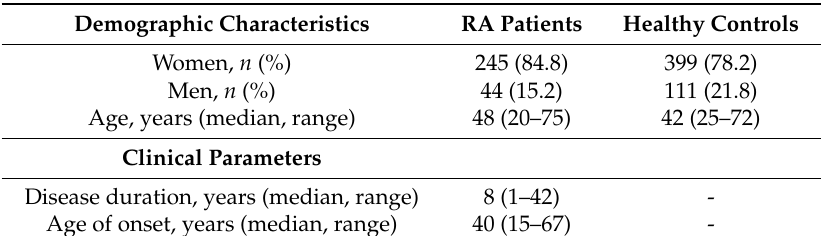
Table 1. Characteristics of the patients with rheumatoid arthritis.